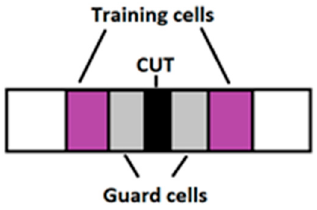
Figure 4. CFAR diagram.